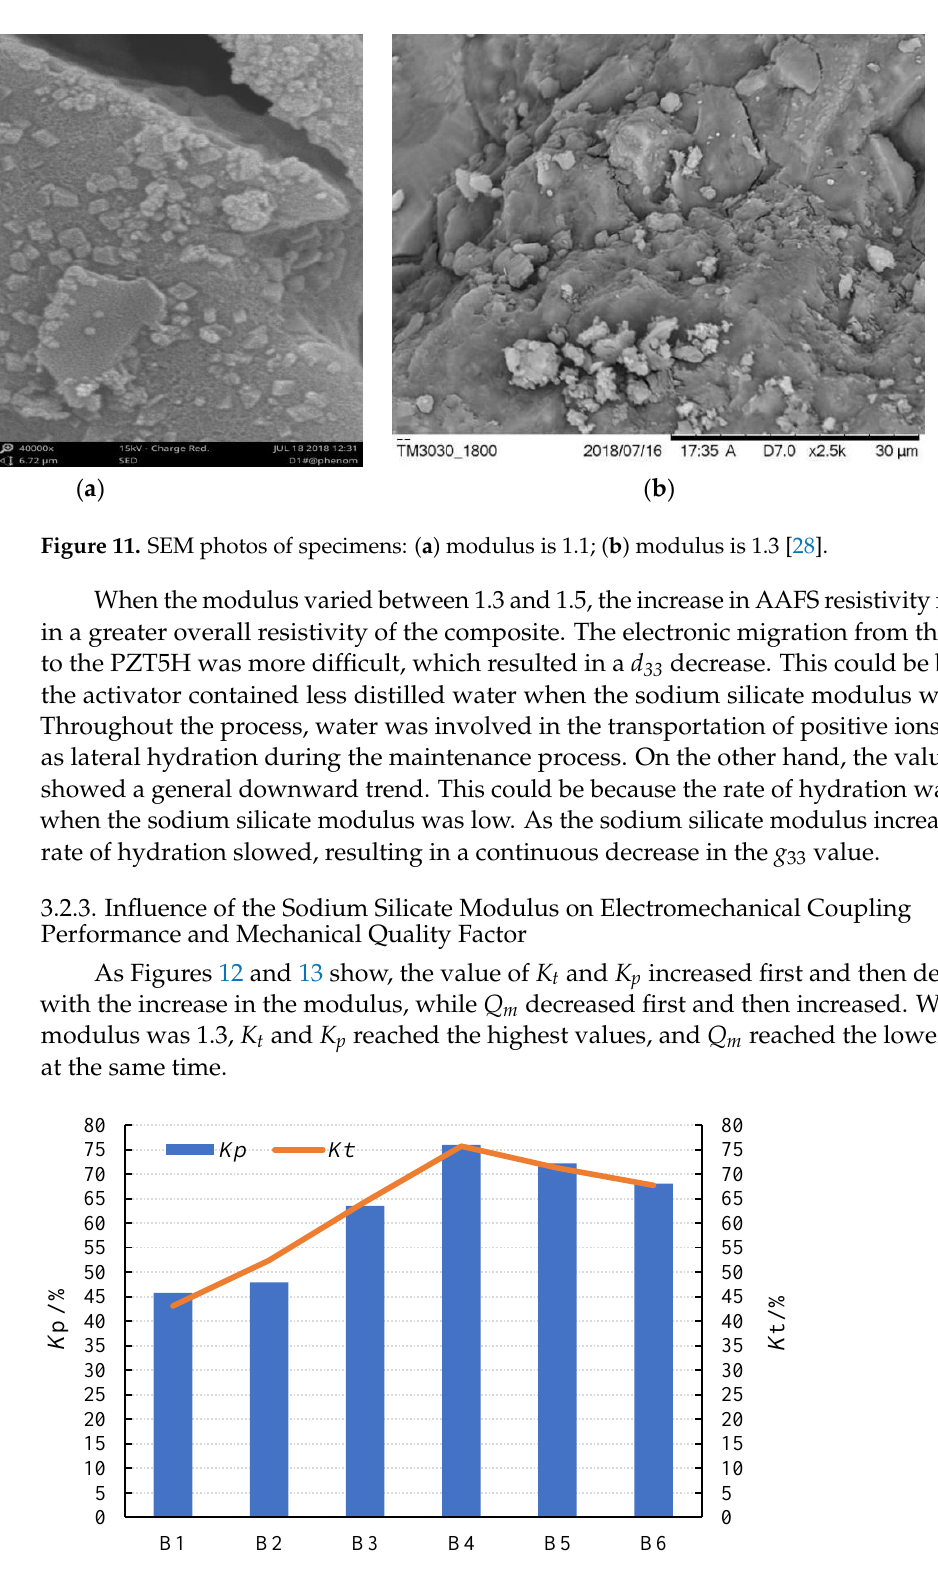
Figure 12. Electromechanical coupling performance.